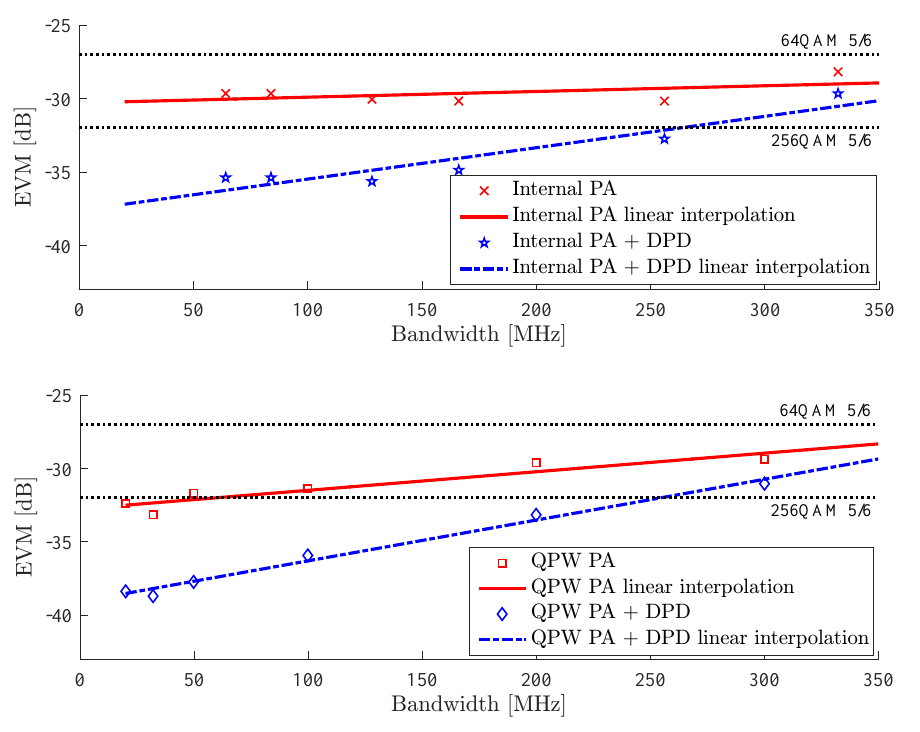
Figure 8. EVM with and without DPD for an OFDM waveform with an internal PA (top) and external QPW-50662330 PA (bottom). Dotted horizontal lines denote typical EVM limits for 64 Quadrature Amplitude Modulation (QAM) and 256 QAM with a code rate of